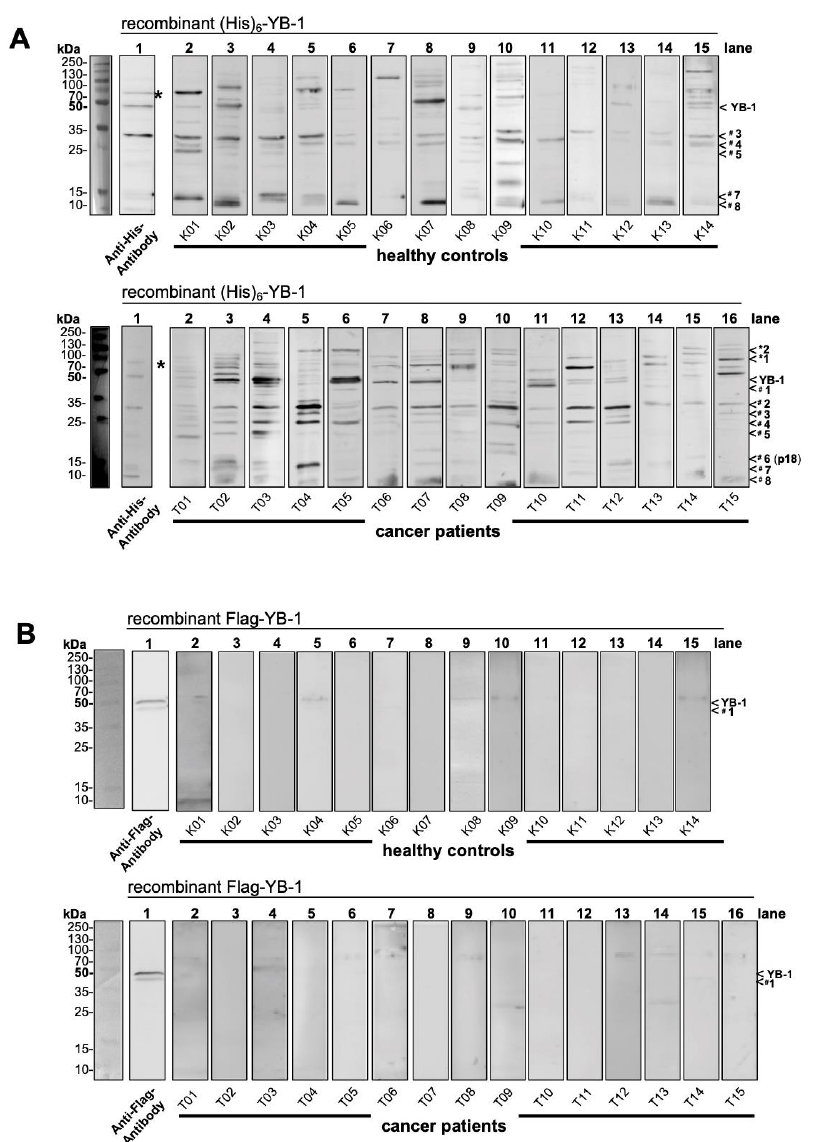
Figure 3. Autoantibody detection with recombinant YB-1 proteins. 2.5 µ g of His-tagged and 1.5 µ g of Flag-tagged YB-1 protein was separated by SDS-PAGE and serum samples from healthy controls and cancer patients were used to probe the blotted proteins as “primary” antibodies. Anti-human IgG Fc antibodies were added as the secondary antibody, followed by visualization with a tertiary anti-mouse antibody. ( A ) His tagged YB-1 protein is detected at about 50 kDa molecular weight by 1 control and 8 cancer patients. Both groups reveal protein bands from 10 kDa until 130 kDa molecular size. Cancer patients reveal antibodies against 8 fragments (#1–#8). Fragment denoted p18 (#6) seems specific in cancer. Bands of molecular size > 100 kDa (*1, *2) are more common in cancer patients. ( B ) Autoantibodies against Flag-tagged YB-1 protein were absent in both cohorts. Only weak bands were seen, not corresponding to anti Flag antibody detected bands at about 50 kDa and 45 kDa (YB-1, #1). The same experimental approach was chosen for the recombinant Flag-tagged antibody expressed in HEK293 cells. Here, the recombinant protein did not degrade and was detected as a duplicate band ~50 kDa (Figure 3B, lane 1). Only faint bands were detected in some serum samples that however were of slightly higher relative molecular weight than full-length YB-1 (~54 kDa).